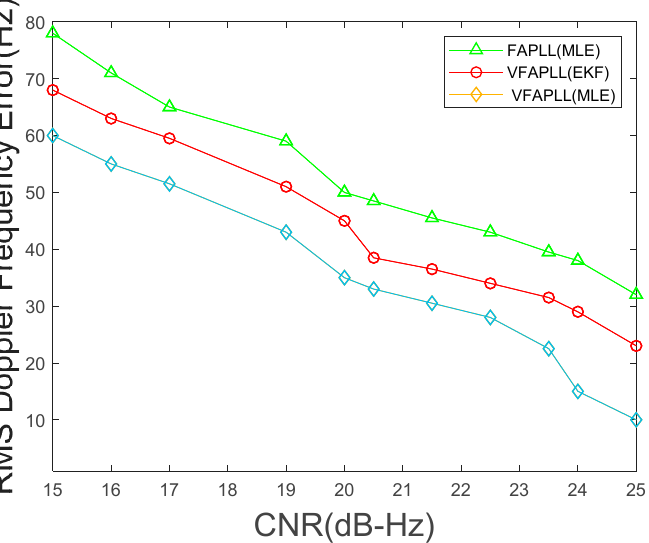
Figure 6. Doppler frequency root mean square error of the VFAPLL (MLE), VFAPLL (EKF) and FAPLL (MLE) at different carrier-to-noise ratios.